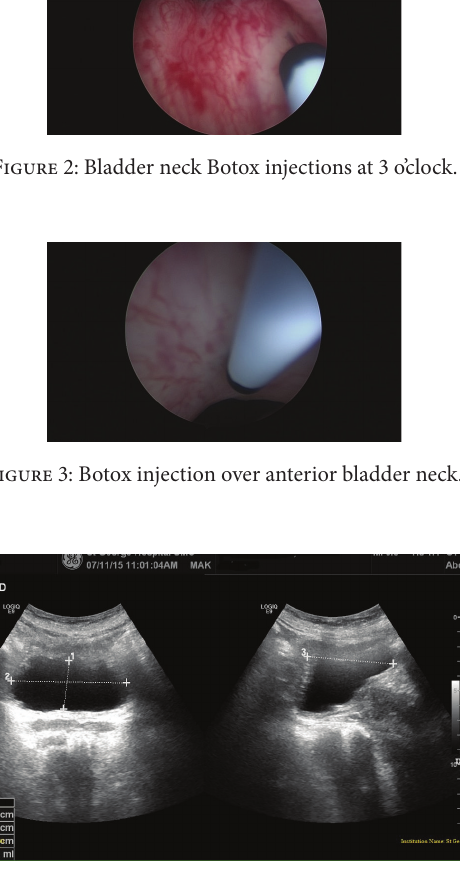
Figure 4: PVR after Botox injections: 78